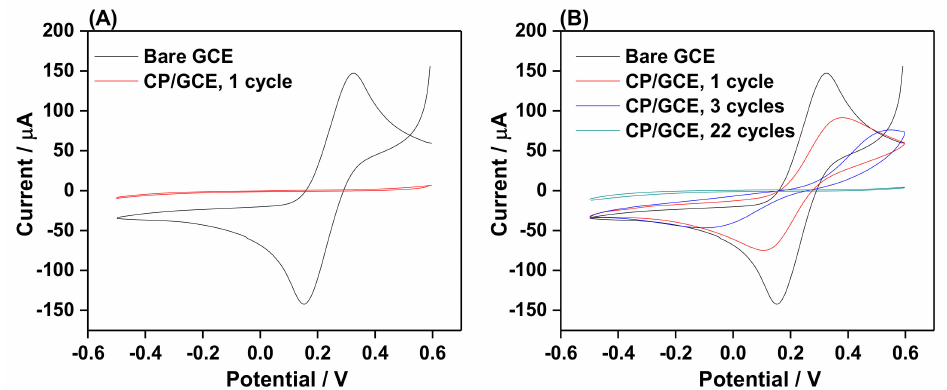
Figure 2. CV for 5.0 mmol / L Fe(CN) 63- / 4- in 100 mmol / L KCl, 0.60 to -0.50 V at 0.10 V.s − 1 : ( A ) bare glassy carbon electrode (GCE) (black) and GCE after grafting with 2.50 mmol / L 4-CBD for 1 cycle, (carboxyphenyl (CP) / GCE, red), ( B ) bare GCE (black) and GCE after grafting with 0.15 mmol / L 4-CBD for 1 cycle (red), 3 cycles (blue), and 22 cycles (dark cyan). CV for grafting: 0.70 to -0.70 V, 0.10 V.s − 1 .